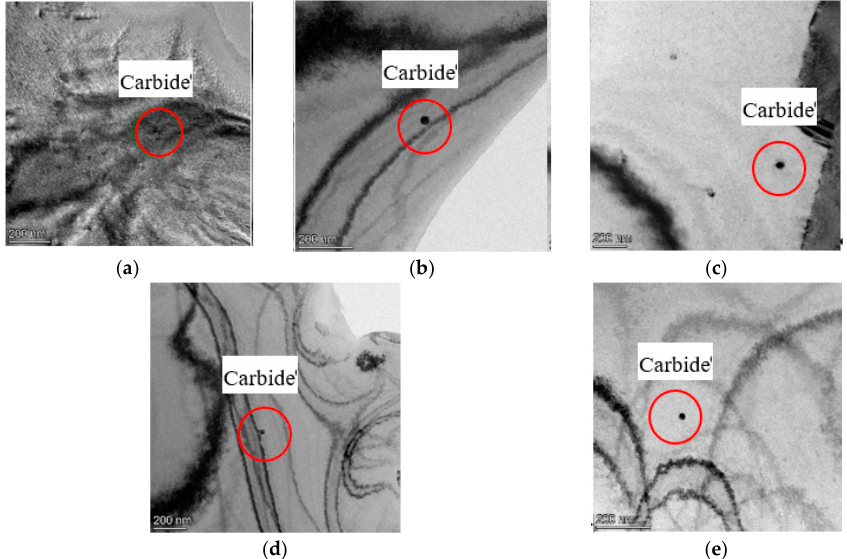
Figure 9. Morphology of precipitates for different cryogenic parameters. ( a ) Specimen #1. ( b ) Specimen #2. ( c ) Specimen #3. ( d ) Specimen #4. ( e ) Specimen #5.